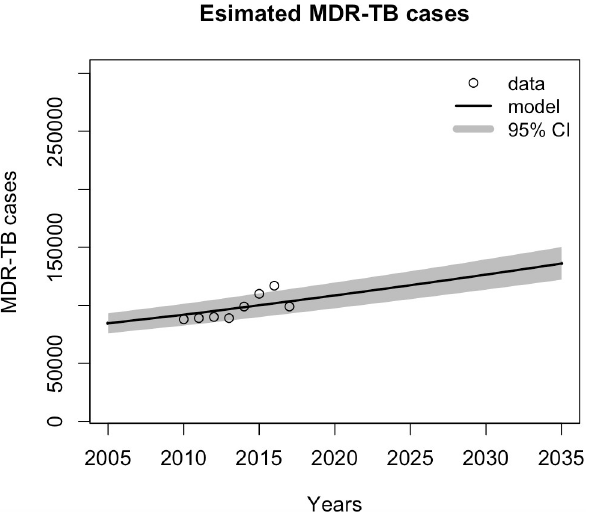
Fig 4. Model projection of estimated numbers of MDR-TB cases. The black line shows the model validation results of numbers of MDR-TB cases, and the dots represent WHO data for the numbers of estimated MDR-TB cases.